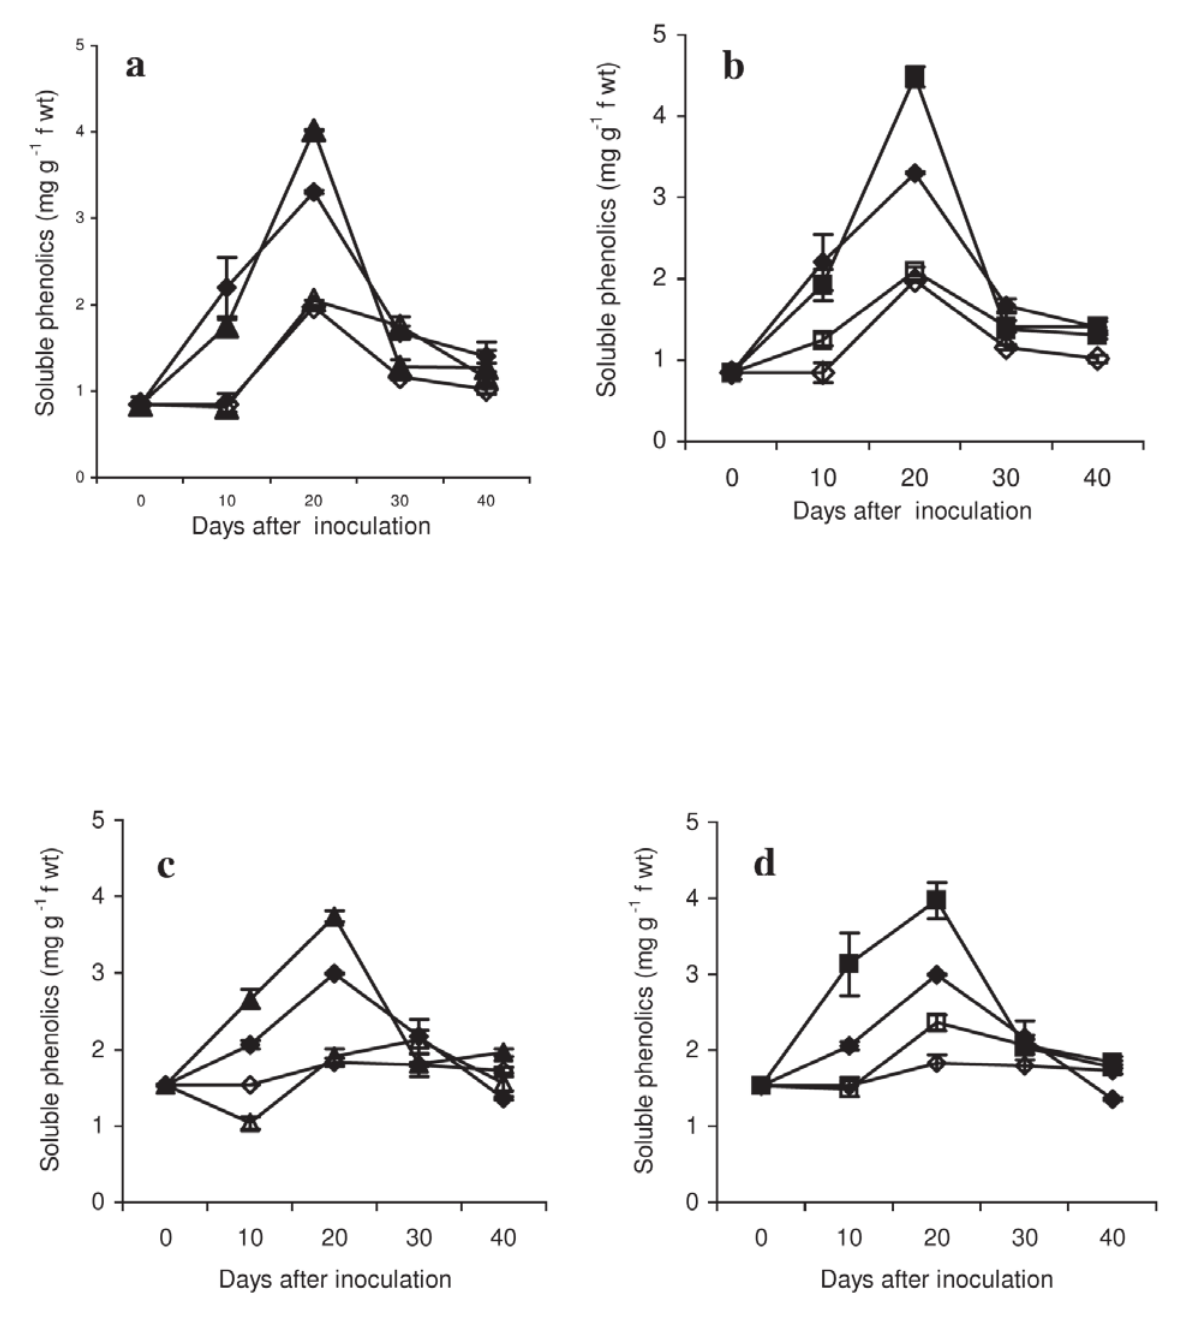
Fig. 1. Time-course diagram of soluble phenolic levels in the roots of the susceptible chickpea cv. ILC482 (a and b) and the moderately resistant cv. INRAT87/1 (c and d) subjected to various treatments (- (cid:1) - water + water; - (cid:2) - Rhizobium isolate PchDMS + water; - (cid:1) - Rhizobium isolate Pch43 + water; - (cid:3) - Water + Foc; - (cid:4) - PchDMS + Foc; - (cid:5) - Pch43 +